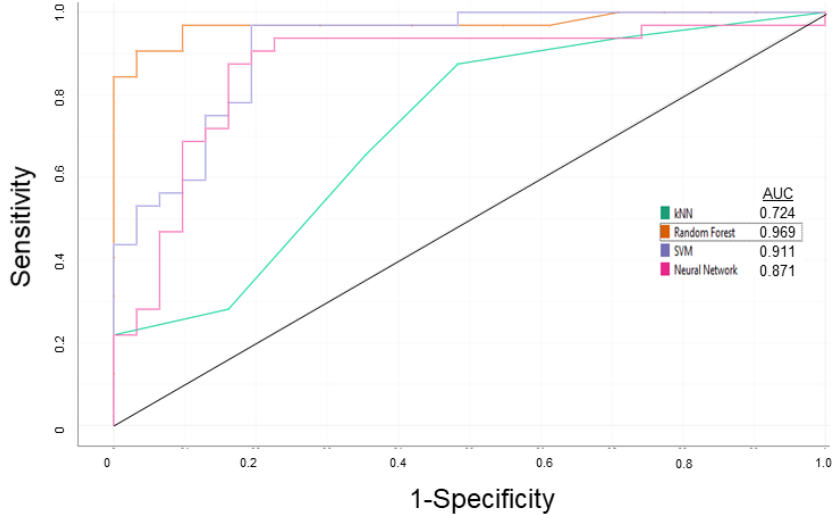
Figure 1. Receiver operating characteristic (ROC) curves of k Nearest Neighboring (kNN), Neural Network, Random Forest (RF), and Support Vector Machine (SVM) classification algorithms based on random leave-one-out sampling for the P-gp modulator/non-modulator prediction model for the learning step. Table 3. Performance of the P-gp modulator/non-modulator prediction model based on the RF classifier algorithm.